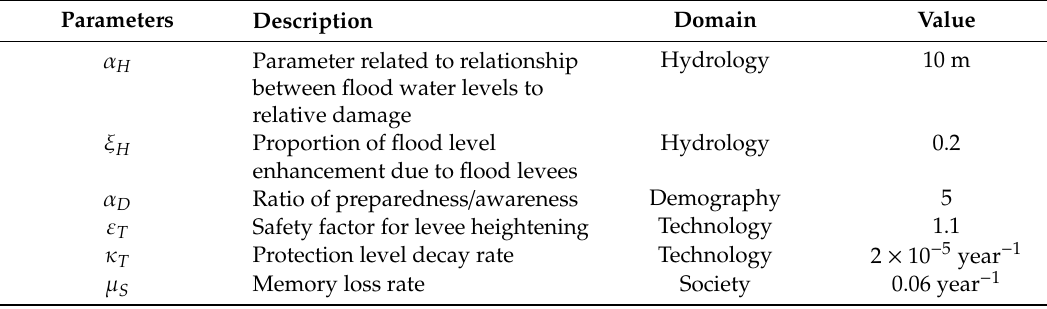
Table 2. Parameters of the model as set in [1].